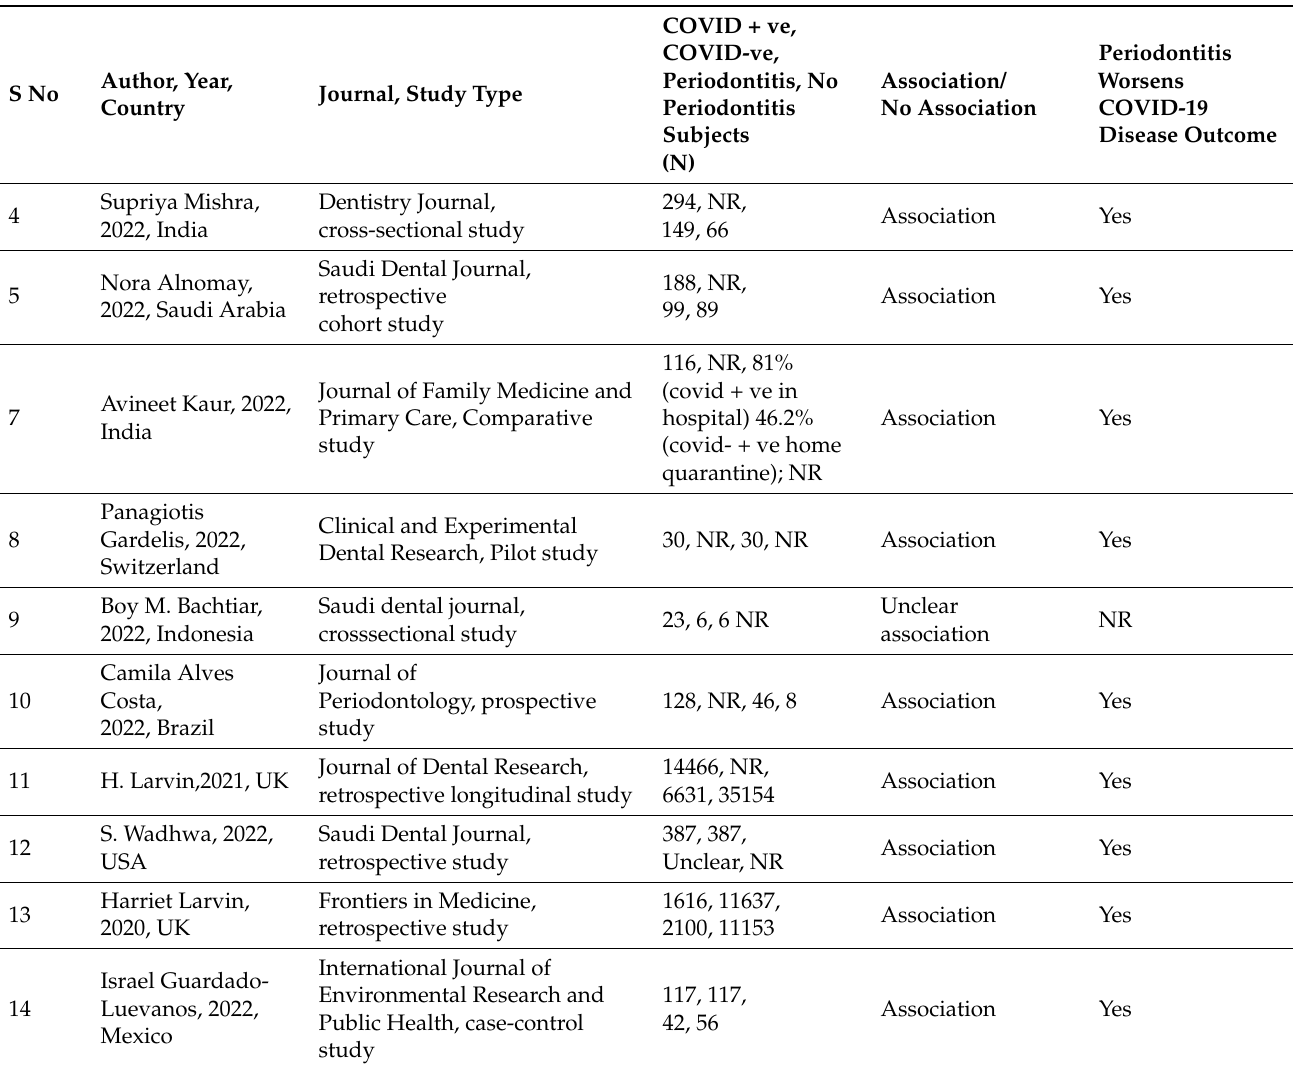
Table legends: Covid + ve = confirmed COVID-19 patients with